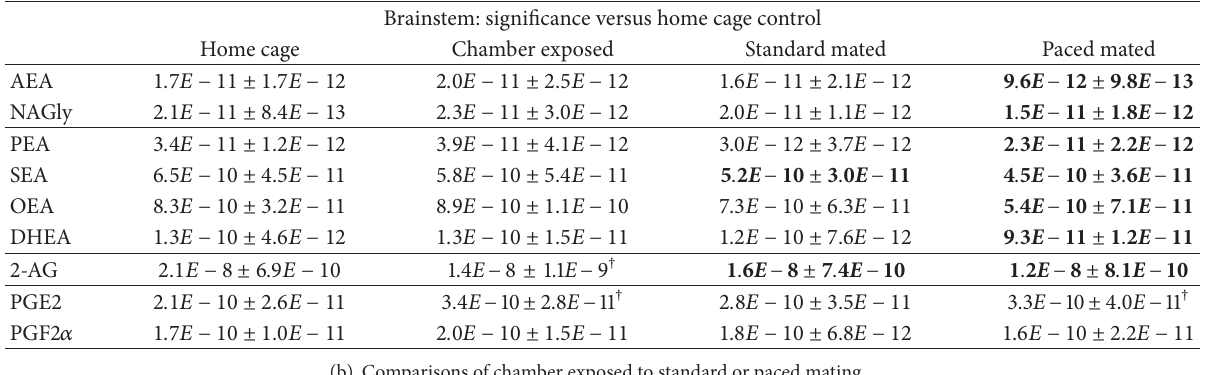
Table 3: Brainstem